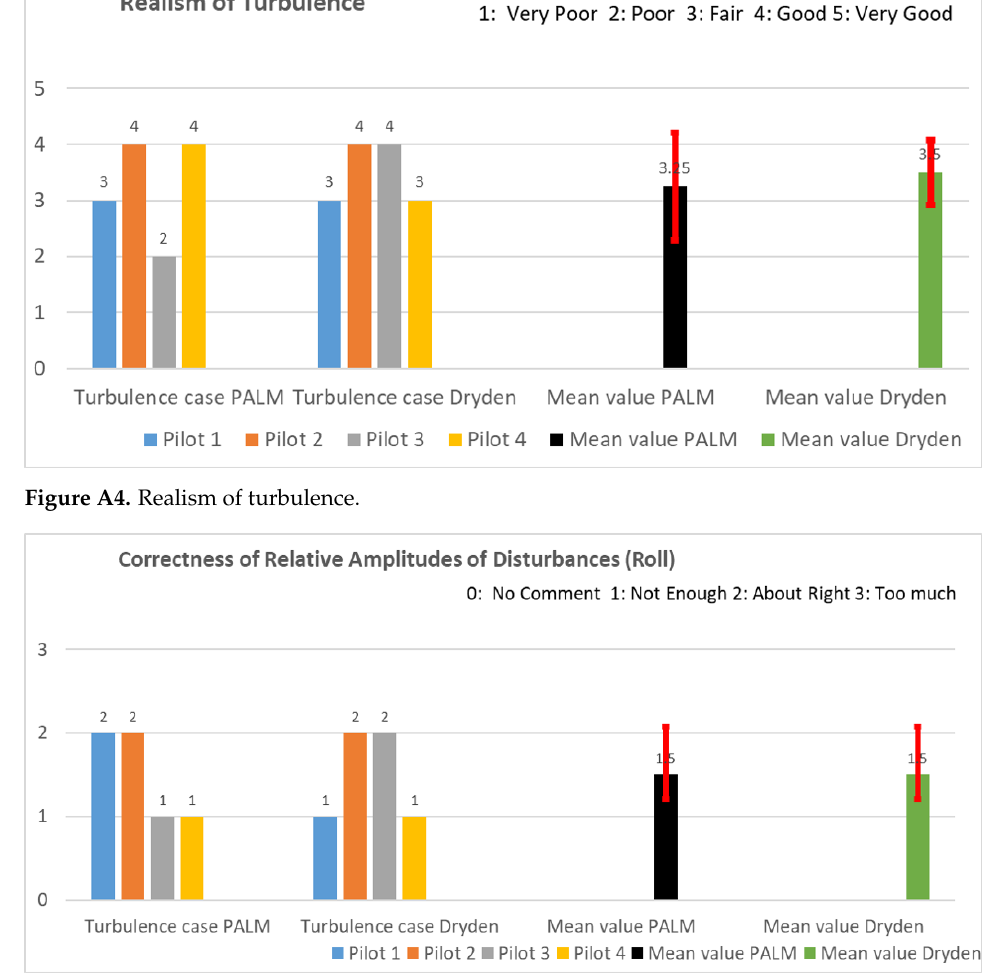
Figure A5. Correctness of relative amplitudes of disturbances (roll).